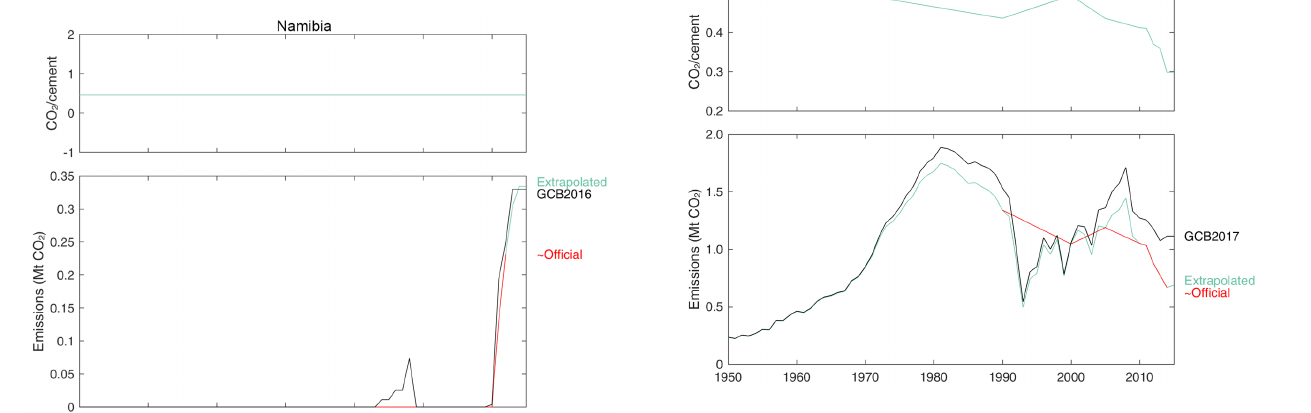
Figure C34. Revised cement emissions in Serbia.